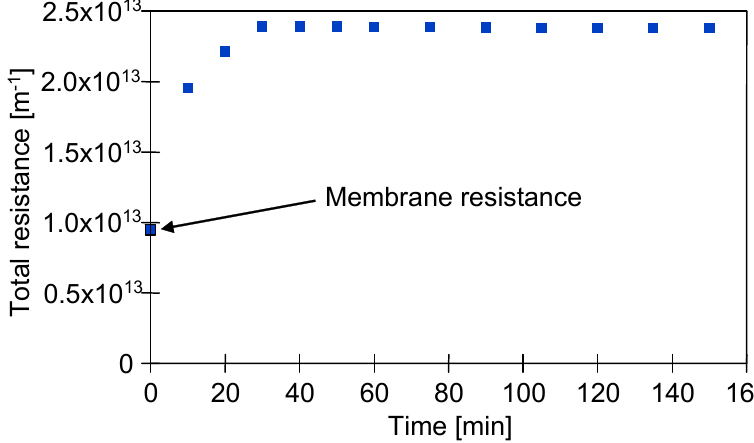
Figure 5. The impact of feed pH on the steady-state permeate flux. TMP = 0.4 MPa and Q = 400 dm 3 / h.